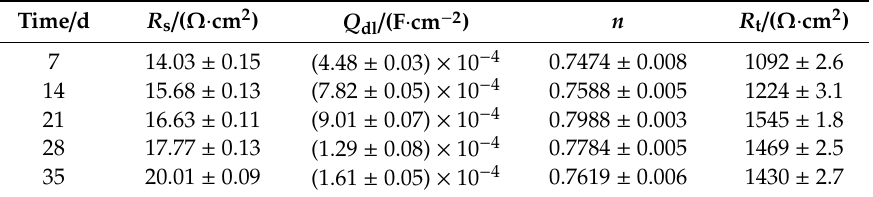
Table 4. Parameters of equivalent circuits obtained by fitting the experimental results of EIS.